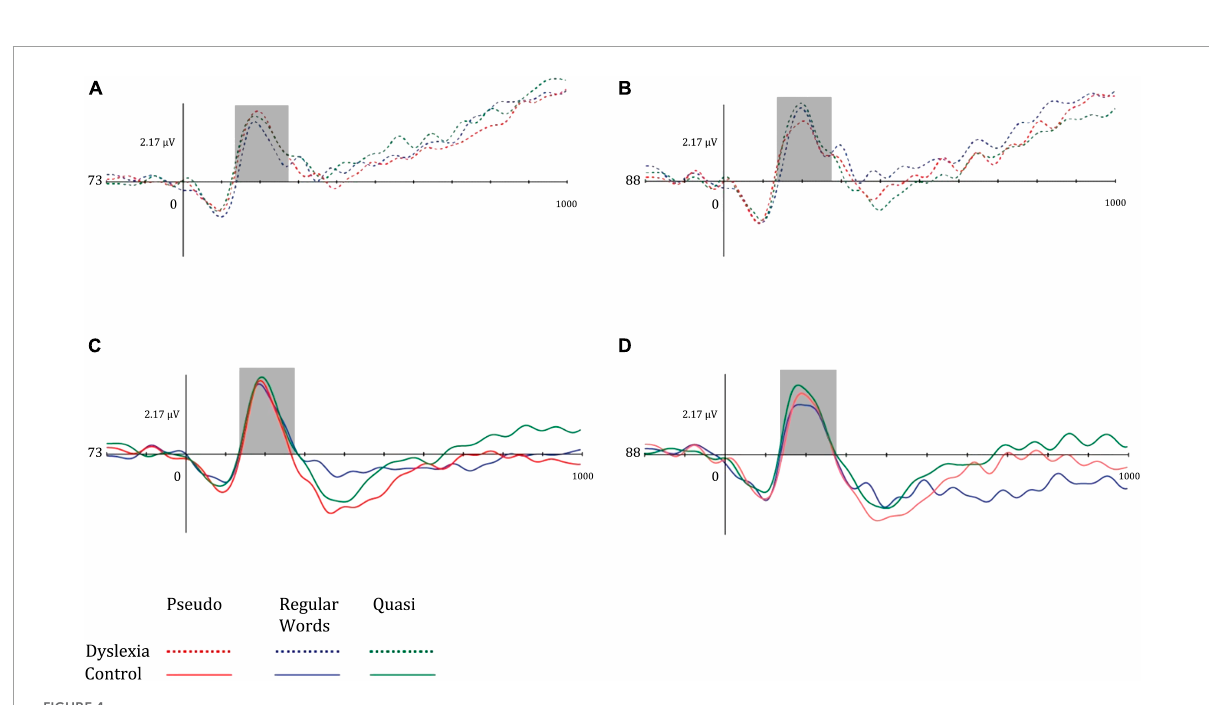
FIGURE4 Mean amplitude of the left occipitotemporal N170 component for (A) dyslexia group and left hemisphere, (B) dyslexia group and right hemisphere, (C) control group and left hemisphere, and (D) control group and right hemisphere. Dotted lines represent the dyslexia group, while solid lines represent the control group. Red-colored lines represent pseudo words, blue-colored lines represent regular words, and green-colored lines represent Quasi